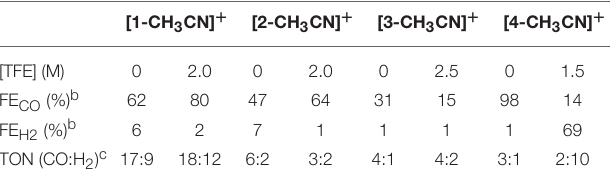
TABLE 4 | Summary of controlled potential electrolysis data in the absence of TFE and at optimum TFE concentrations a .